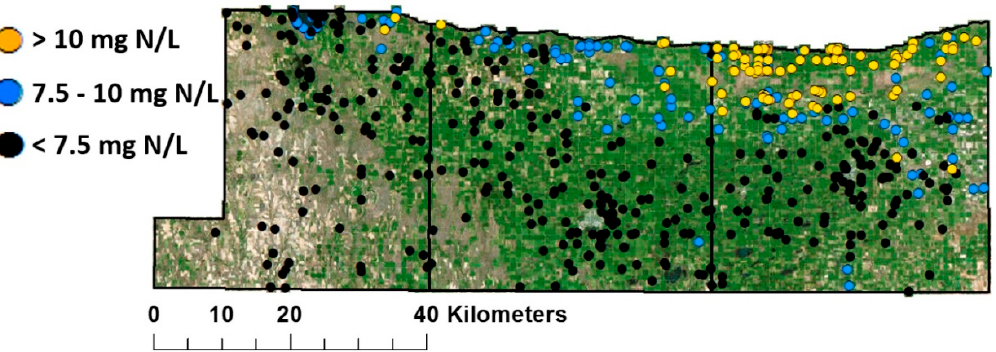
Figure 5. Wells predicted to surpass the 7.5 and 10 mg NO 3 -N/L thresholds under intensive cropping systems from 2009 to 2015 in the three counties that make up the Tri-Basin Natural Resources District. Only predicted wells are shown; other wells with nitrate data were used as inputs to develop the model.